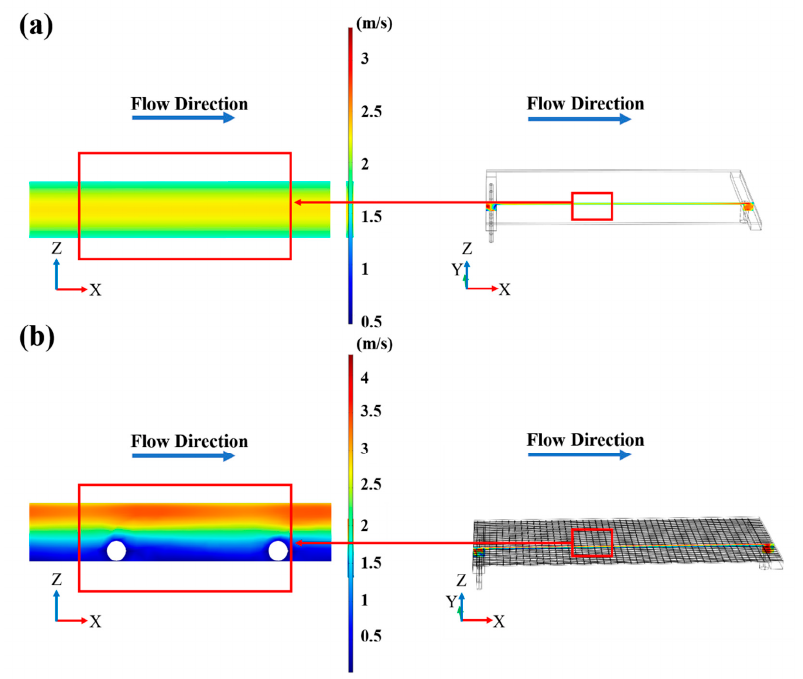
Figure 9. The velocity distribution of the inner section of the membrane chamber ( a ) without the turbulence promoter and ( b ) with the turbulence promoter (inlet velocity = 8 m/s).